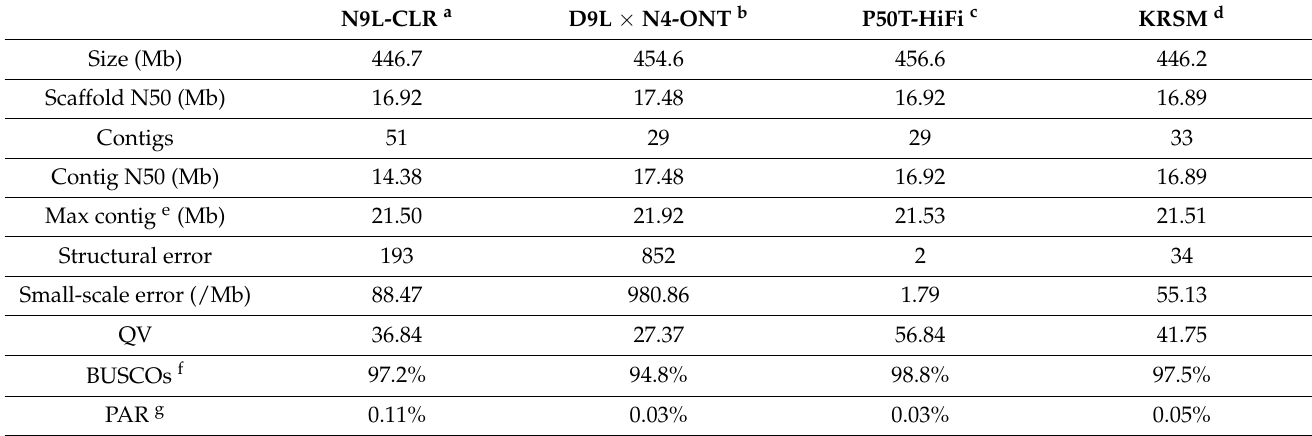
Table 3. Statistics of different silkworm chromosome-level genome